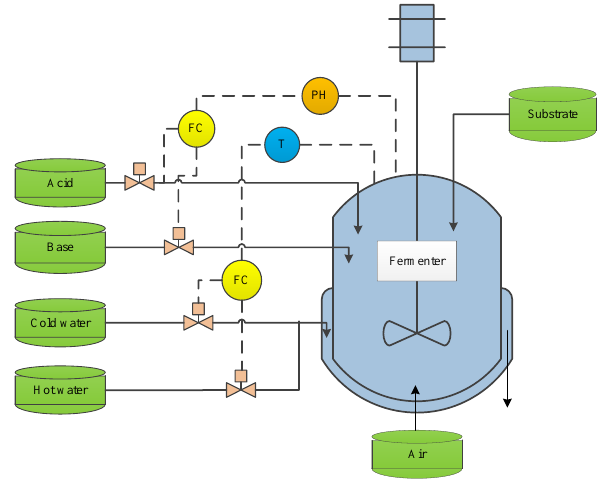
Figure 5. Schematic diagram of penicillin fermentation process (PFP).